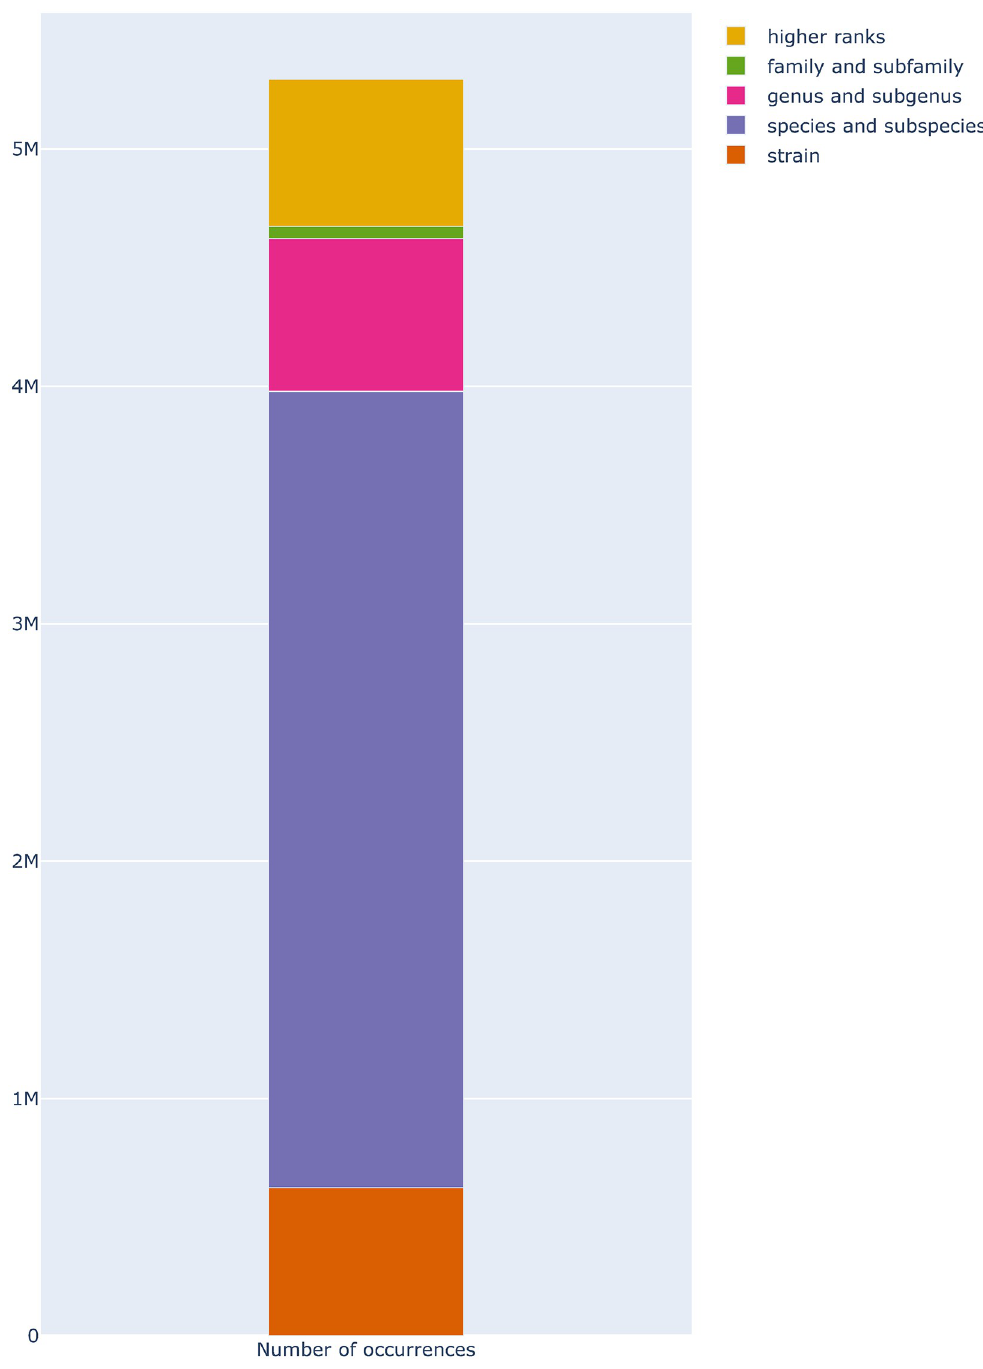
Fig 4. Distribution of taxa ranks in Lives_In relations in Omnicrobe. “Strain” ranks comprise strains and isolates. “Species and subspecies” ranks include species and ranks below species and above strain ( e . g ., subspecies, varieties, morph). “Genus and subgenus” ranks include genus and ranks below genus and above species ( e . g ., subgenus, section, series). “Family and subfamily” ranks consist of family and ranks below family and above genus ( e . g ., subfamily, tribe). “Higher ranks” include all ranks above the family ( e . g . order, class, phylum, kingdom). The height of the bars is proportional to the number of Lives_In relations in Omnicrobe.